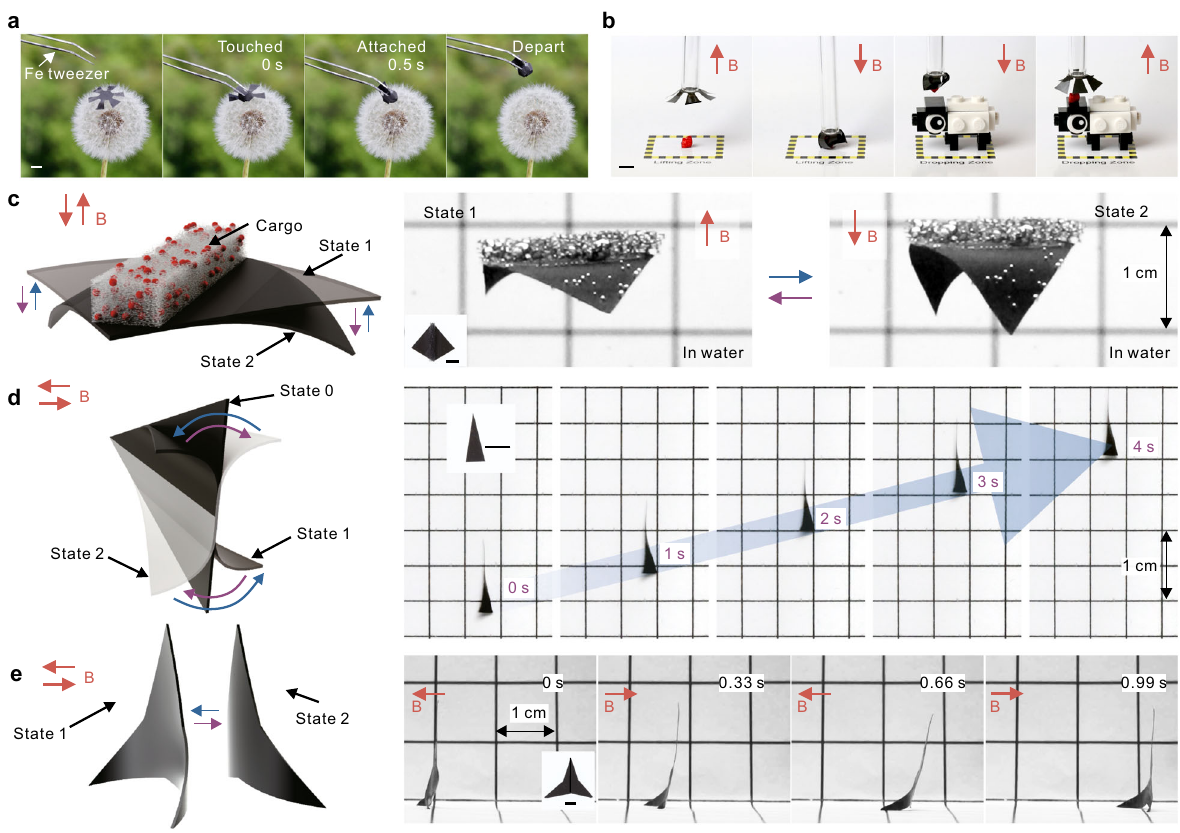
Fig. 4 Ultrafast soft robots that self-attach, transport cargo, and swim. a A six-arm robot on a dandelion can self-grip when approaching magnetic tweezers without harming the fragile structure of the fl ower (Supplementary Movie 9). b The same robot can also grab, transport, and release nonmagnetic objects such as a polyurethane foam cube controlled by a permanent magnet (Supplementary Movie 10). c Manta ray-shaped robot with a cargo swimming in water (Supplementary Movie 11). d Triangle-shaped swimming robot twisting around its main axis and therefore moving forward in the water, both driven by a square wave magnetic fi eld (Supplementary Movie 12). e Triangle-shaped walking robot rolling itself in air at high speeds when subjected to an alternating magnetic fi eld (Supplementary Movie 13). Scale bars, 0.5